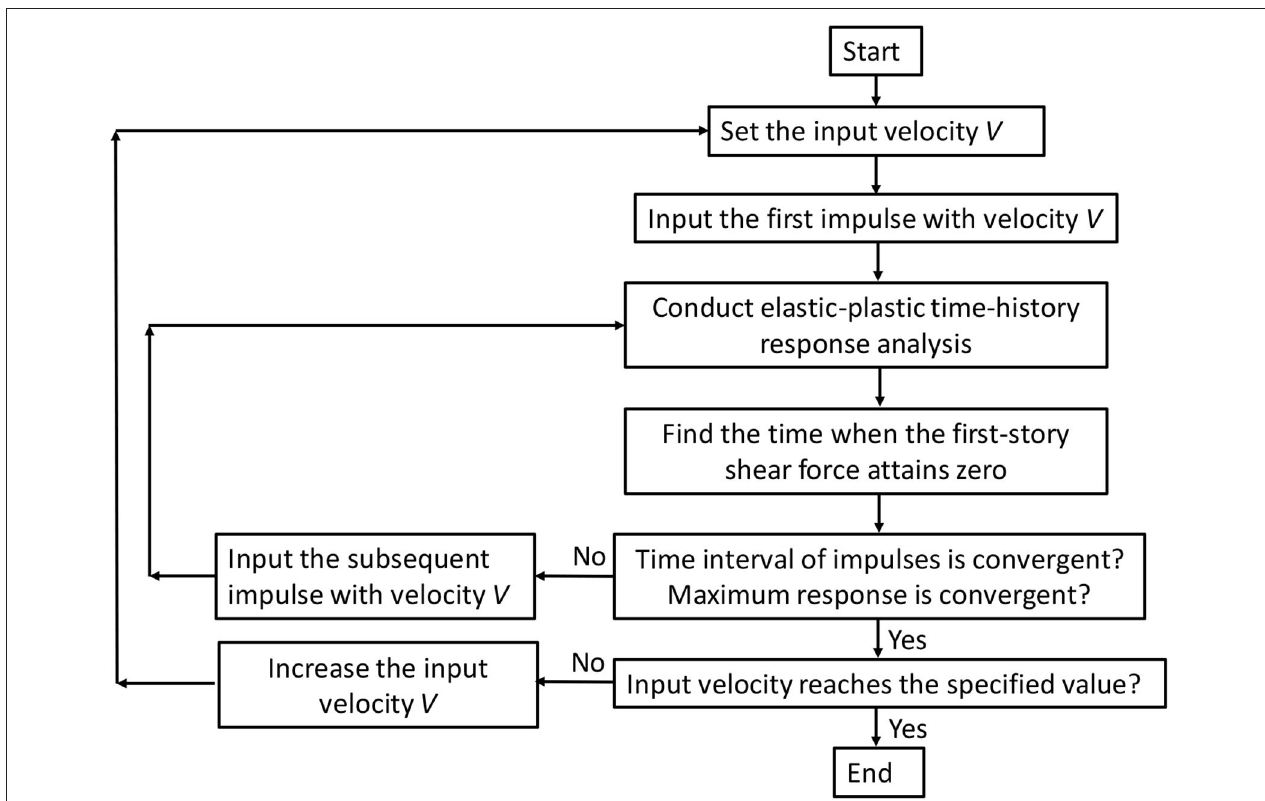
FIGURE 7 | Flowchart for Multi Impulse Pushover (MIP) analysis.